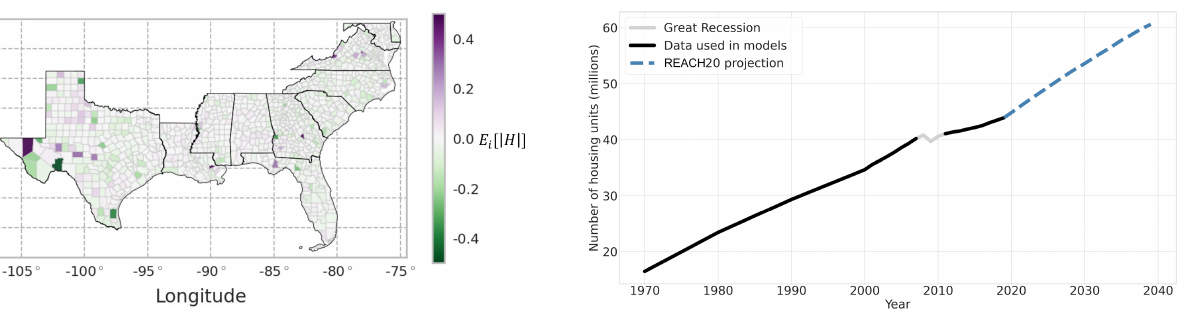
Figure 6. Predicted number of housing units in the study area using the REACH20